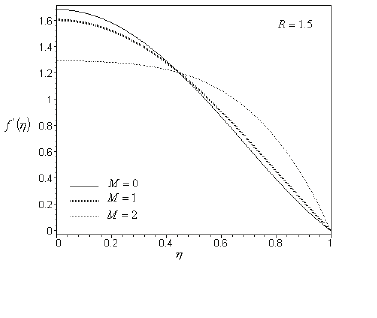
Figure 2. The normal velocity profiles for different values of magnetic parameter M, when R = 1 . 5 is fixed.